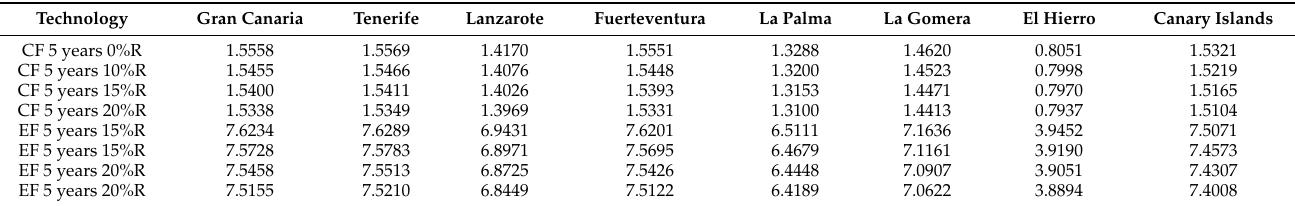
Table 16. Carbon Footprint (CF) and Ecological Footprint (EF) for lowest energy consumption case in the Canary Islands. Year 2017.